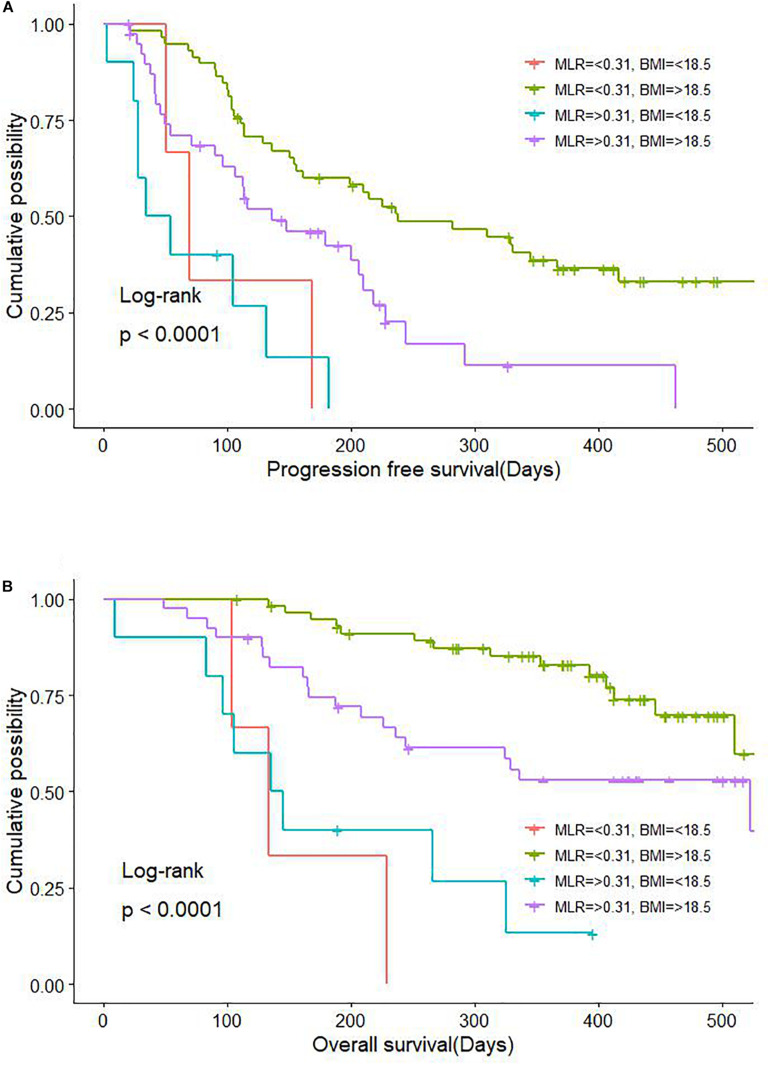
Combinatorial effect of MLR and BMI on survival in GC and CRC. (A) Effect on PFS. (B) Effect on OS. BMI, body mass index; CRC, colorectal cancer; GC, gastric cancer; MLR, monocyte-to-lymphocyte ratio; PFS, progression-free survival; OS, overall survival.